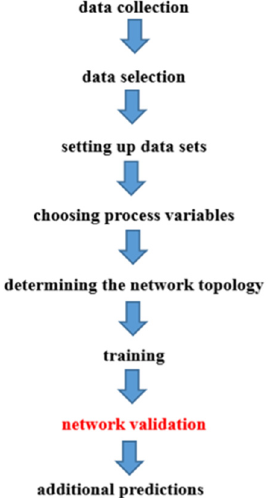
Figure 1. Stages of modeling with neural networks.